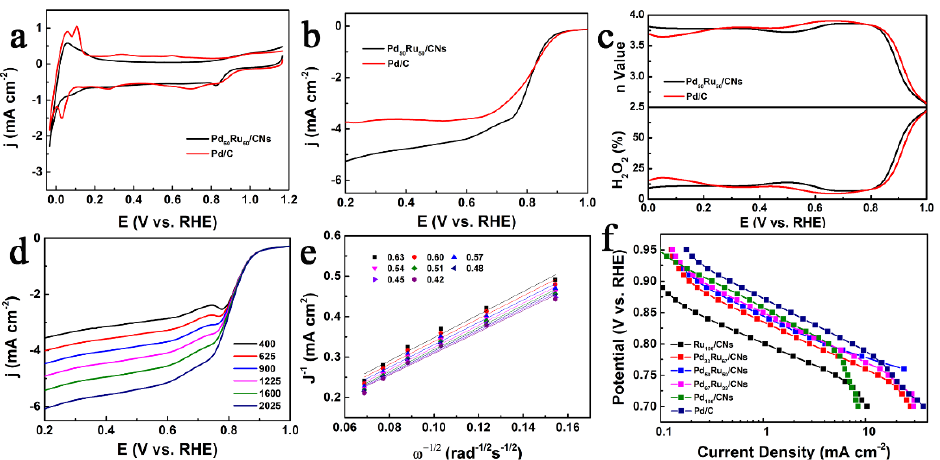
Figure 3. ( a ) Cyclic and ( b ) RRDE curves, ( c ) plots of H 2 O 2 yield, and electron transfer number of the Pd 50 Ru 50 /CNs and Pd/C catalysts. ( d ) linear sweep voltammograms (LSV) curves for Pd 50 Ru 50 /CNs at the rotation rates of 400–2025 rpm. ( e ) The Koutecky–Levich (K–L) plots for Pd 50 Ru 50 /CNs at various potentials. ( f ) Tafel plots of all of the samples and commercial 10 wt.% Pd/C. All of the measurements were performed in an oxygen-saturated 0.1 M KOH aqueous solution at a potential scan rate of 10 mV s −1 .